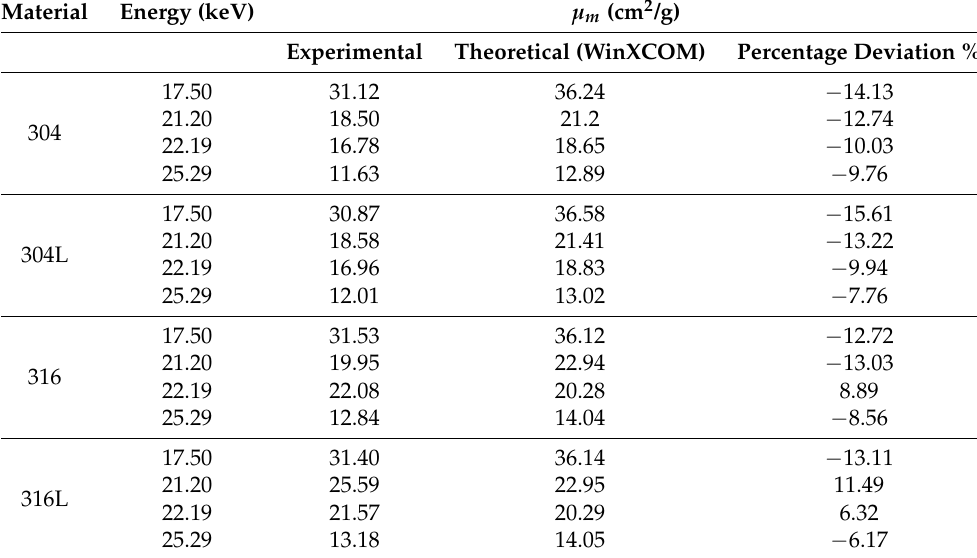
Table 3. Mass attenuation coefficients (cm 2 /g) of 304, 304L, 316 and 316L stainless-steel samples measured experimentally and compared with theoretical values using